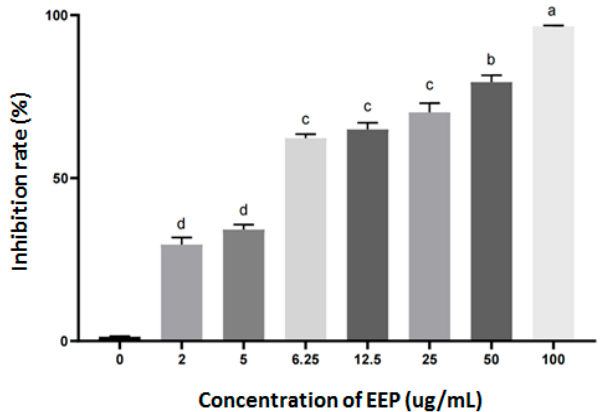
Figure 1. Inhibition rates of SU-DHL-2 cell proliferation by different concentrations of EEP for 24 h. Different letters indicate statistical differences between groups ( p < 0.05).